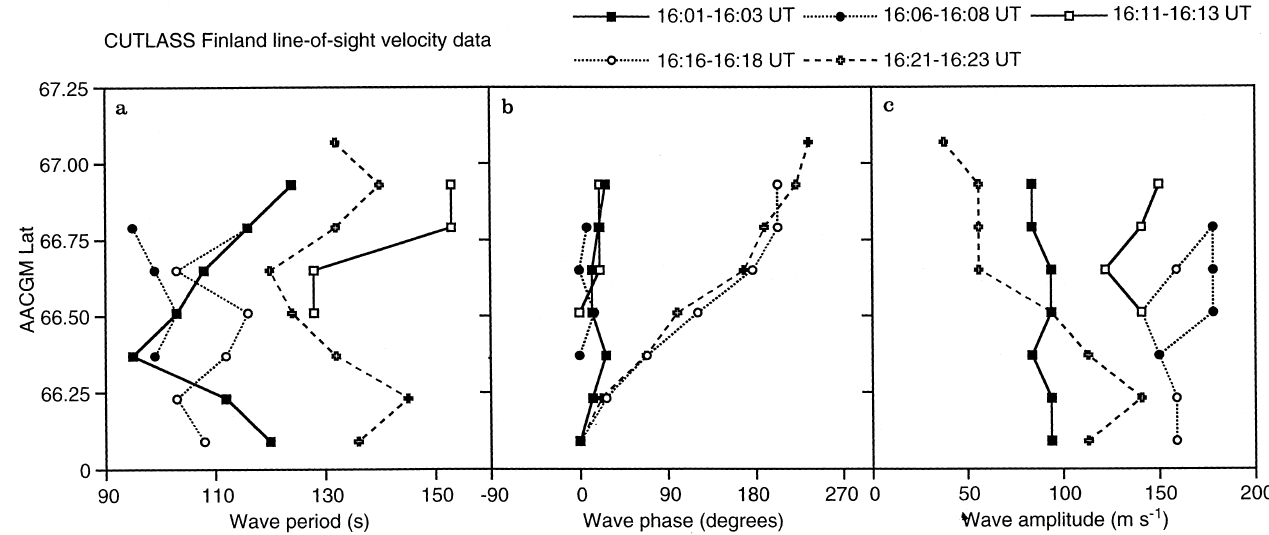
wave amplitude. Each panel presents parameters derived from five sub-intervals of the wave packet at 1601–1603, 1606–1608,